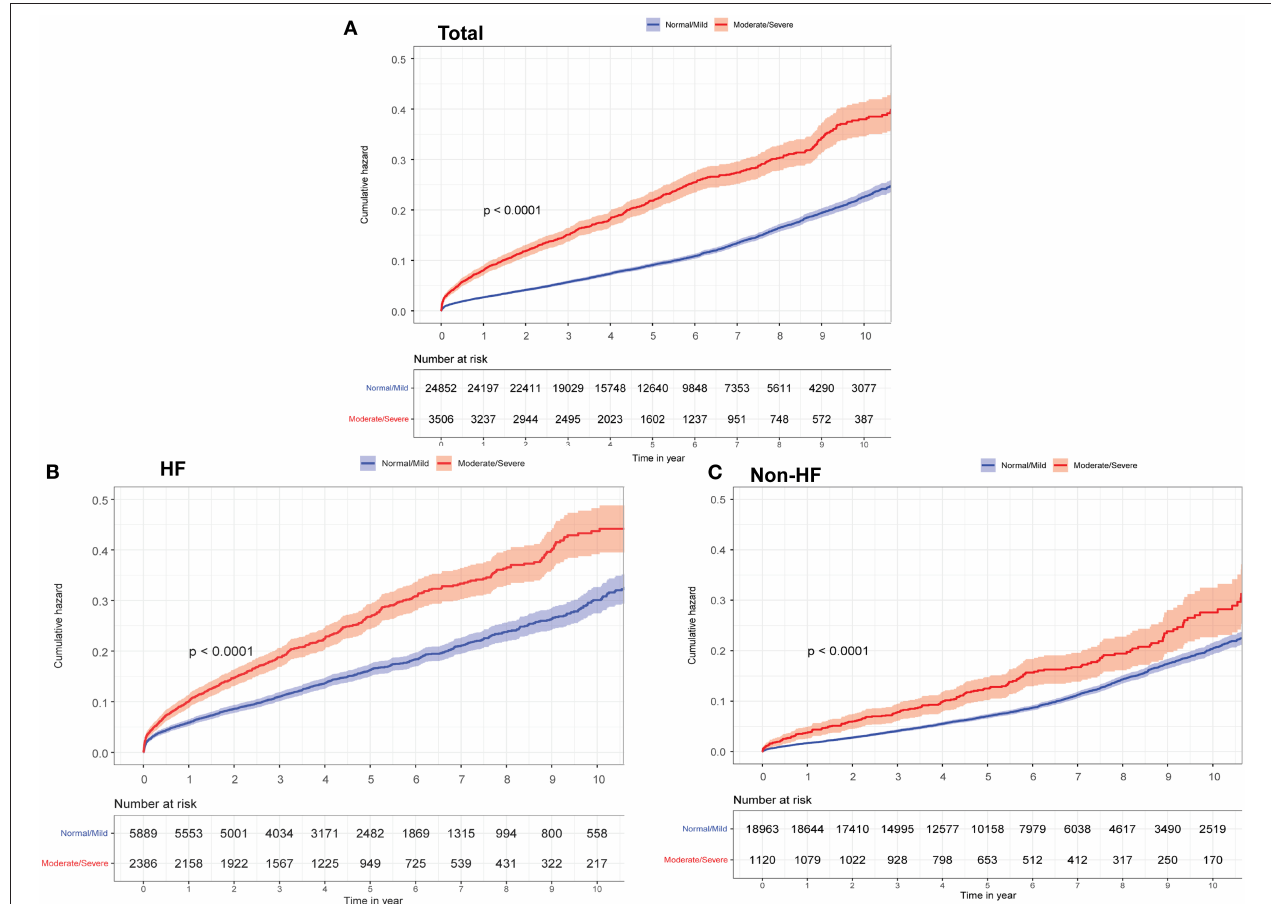
FIGURE 2 | Kaplan-Meier curves for long-term all-cause mortality among different groups according to heart failure (HF) and mitral regurgitation (MR) severity. (A) Total. (B) HF. (C) Non-HF.